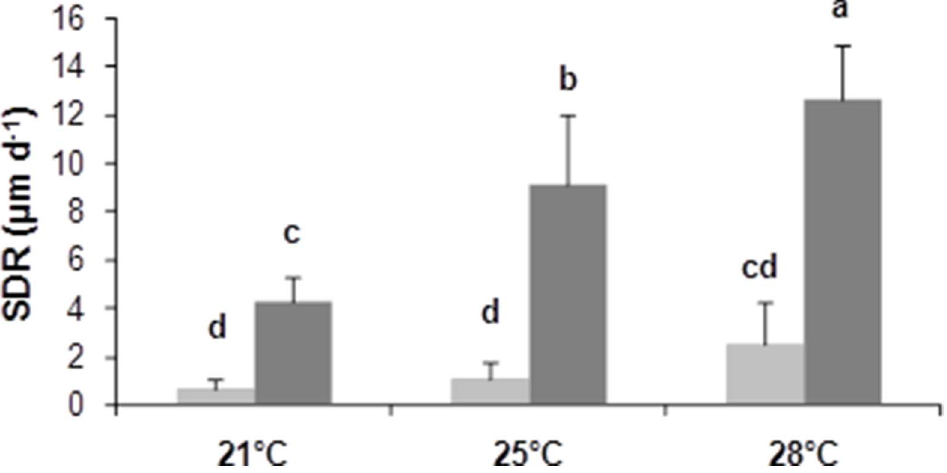
Figure 2. Shell deposit rate ( m m.d 2 1 ) on the ventral side of the shell according to temperature and food concentrations over the two month experiment. Three temperatures (21, 25 and 28 u C) and two microalgal concentrations (800 cell mL 2 1 : light grey and 15000 cell mL 2 1 : darkgrey) were tested. The five homogeneous groups identified by the Tukey post-hoc test (a, b, c and d) are indicated (means and standard error,